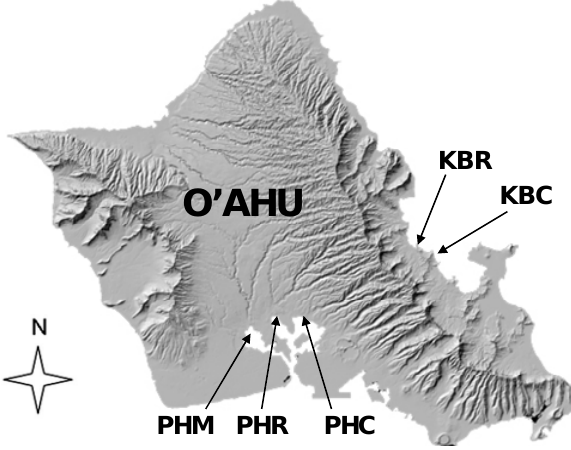
Fig. 1. Location of the 5 sampling sites on the island of O’ahu,